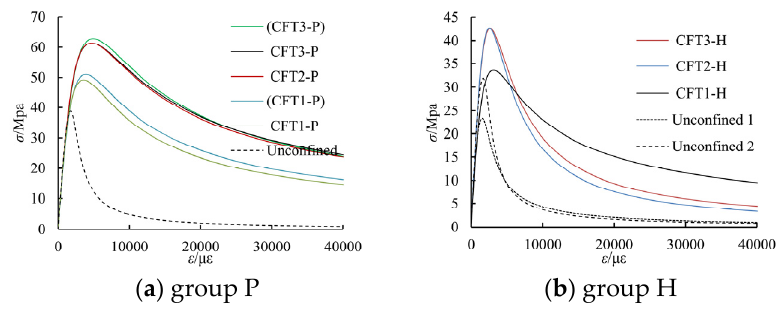
Figure 16. The estimated stress ‐ strain relationship for confined concrete.